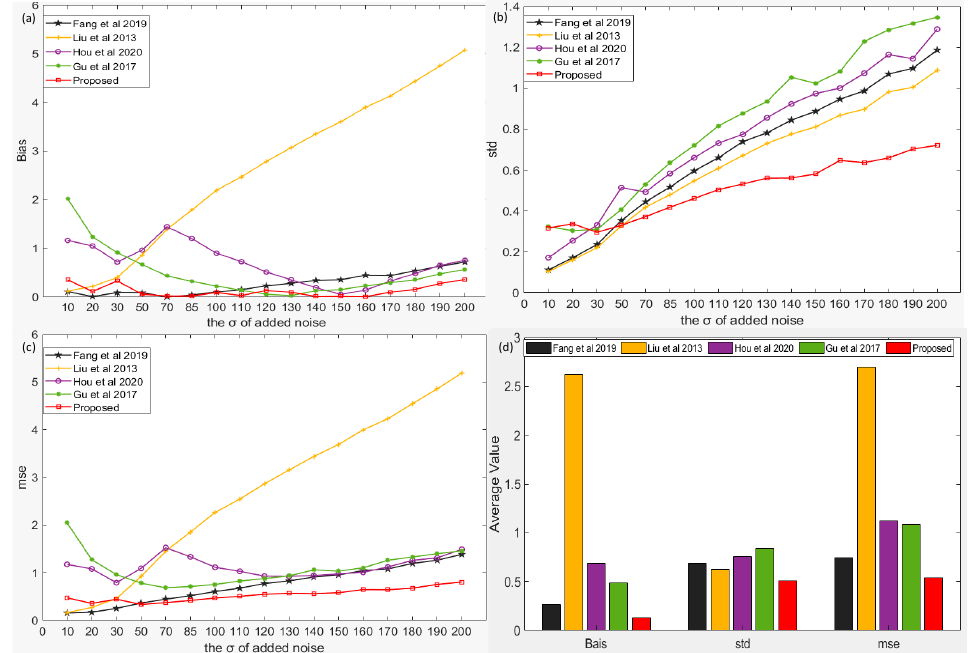
Figure 5. Comparison of the results of our algorithm and four existing algorithms [34,36,38,49] under BSD68 dataset. ( a ) the bias of noise estimation results of five algorithm under different noise levels, ( b ) the std of noise estimation results of five algorithm under different noise levels, ( c ) the mse of noise estimation results of five algorithm under different noise levels, ( d ) the average value of noise estimation results of five algorithm under different noise levels.